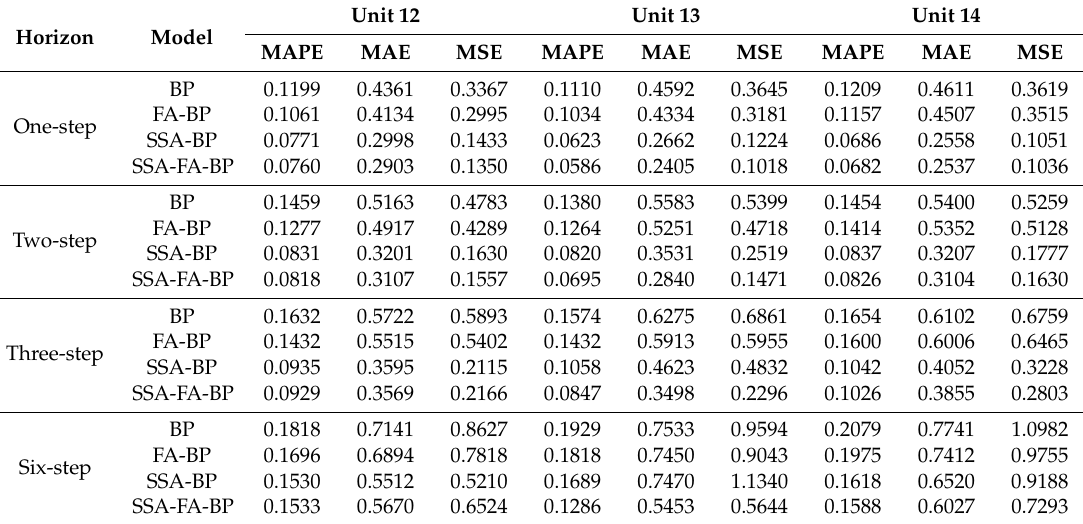
Table 3. The quarterly average forecast results of the combined model and the results of the other models involving the data of three units (10